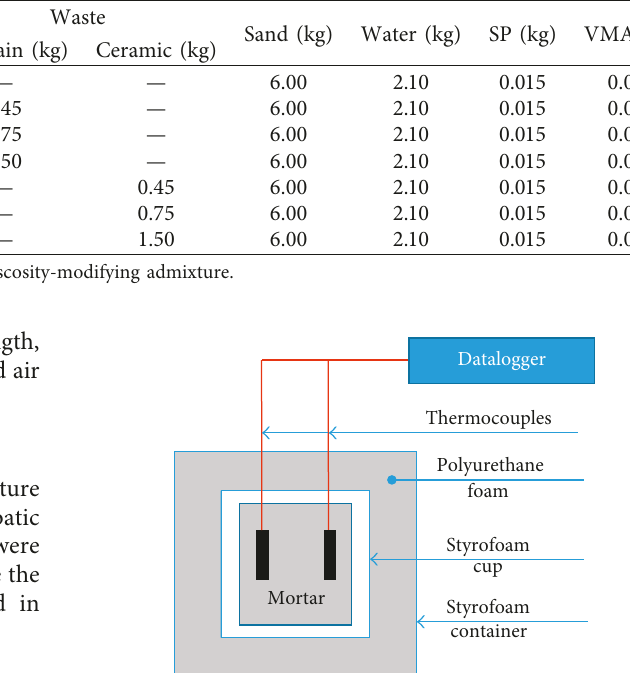
Figure 2: Scheme of the device to determine the kinetics of